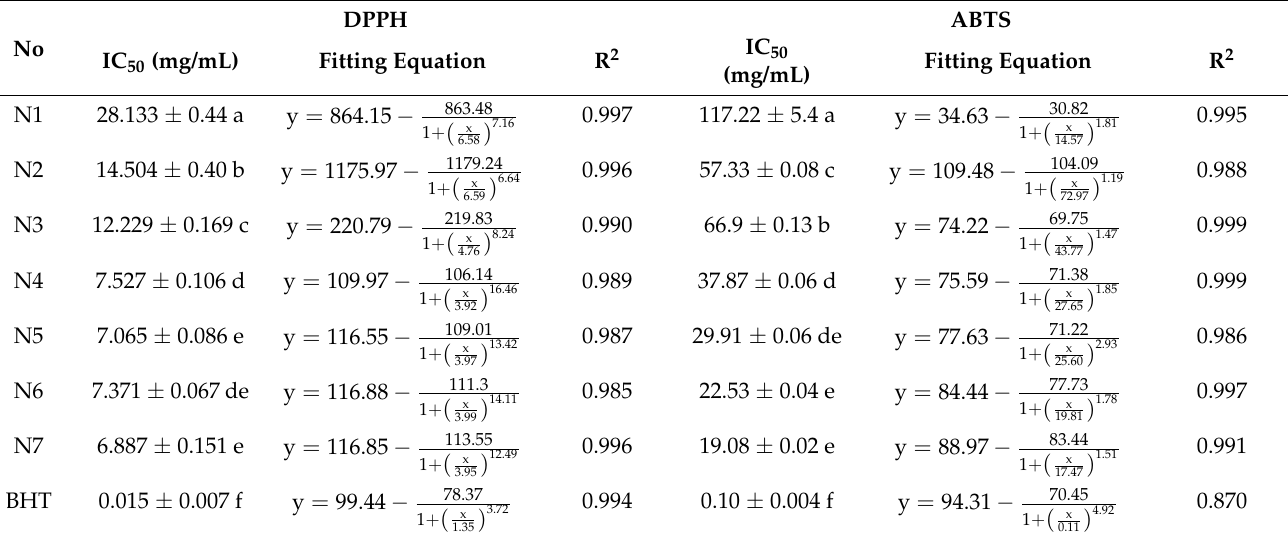
(Figure 2). The coefficients of determination of the logistic curve models of N1, N2, N3, N4, N5, N6, N7 and BHT were elevated to 0.997, 0.996, 0.990, 0.989, 0.987, 0.985, 0.996 and 0.994, respectively, and all F-test values were less than 0.001. The anti-radical activity fell into the following descending order: BHT > N7 > N5 > N6 > N4 > N3 > N2 > N1, with significant differences according to Duncan’s test with 1% significance. The IC 50 values of seven EOCC were ranged from 6.887 ± 0.151 mg/mL to 28.133 ± 0.44 mg/mL. The most active DPPH radical scavenging activity was N7 (IC 50 = 6.887 ± 0.151 mg/mL), followed by N5 (IC 50 = 7.065 ± 0.086 mg/mL) and the lowest DPPH radical scaveng- ing activity was N1 (IC 50 = 28.133 ± 0.44 mg/mL). The scavenging activity of BHT (IC 50 = 0.015 ± 0.007 mg/mL) for the DPPH radical was superior to that of EOCC. Table 3. Scavenging activity of the EOCC against DPPH and ABTS free radicals.